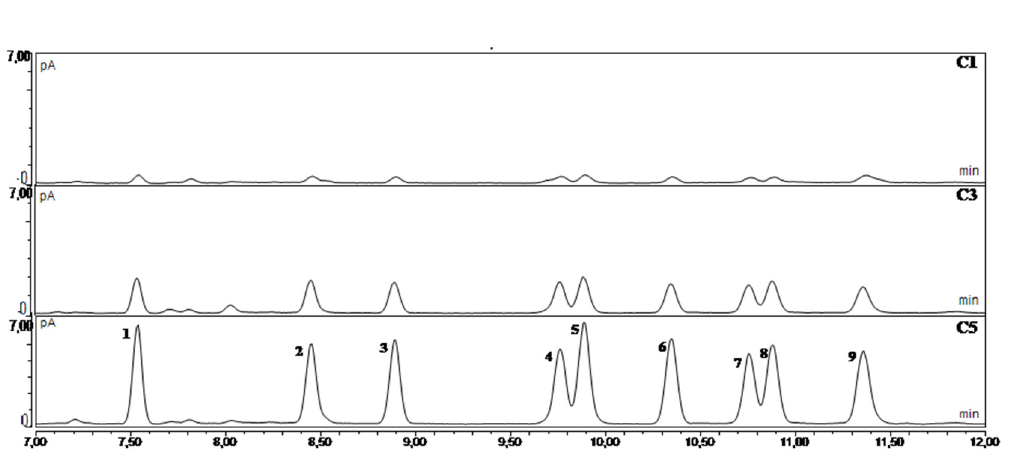
Figure 1. Overlay of chromatograms obtained from the analysis of the solutions of standards C1, C3, and C5 applying the revised method. Compounds identification: (1) Methyl palmitate, (2) ethyl palmitate, (3) methyl heptadecanoate (internal standard), (4) methyl linoleate, (5) methyl